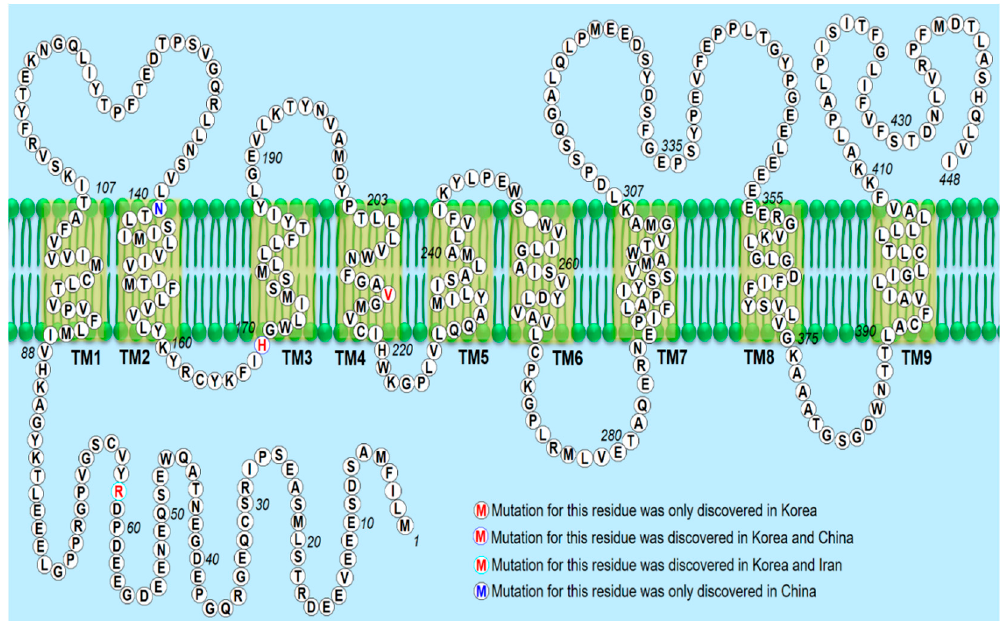
Figure 4. Mutated PSEN2 residues identified in the Asian countries are shown in different colors. The predicted membrane topology of PSEN2 with the nine transmembrane domains (yellow shaded boxes) and boundaries between coding exons are shown. TM, transmembrane domain.